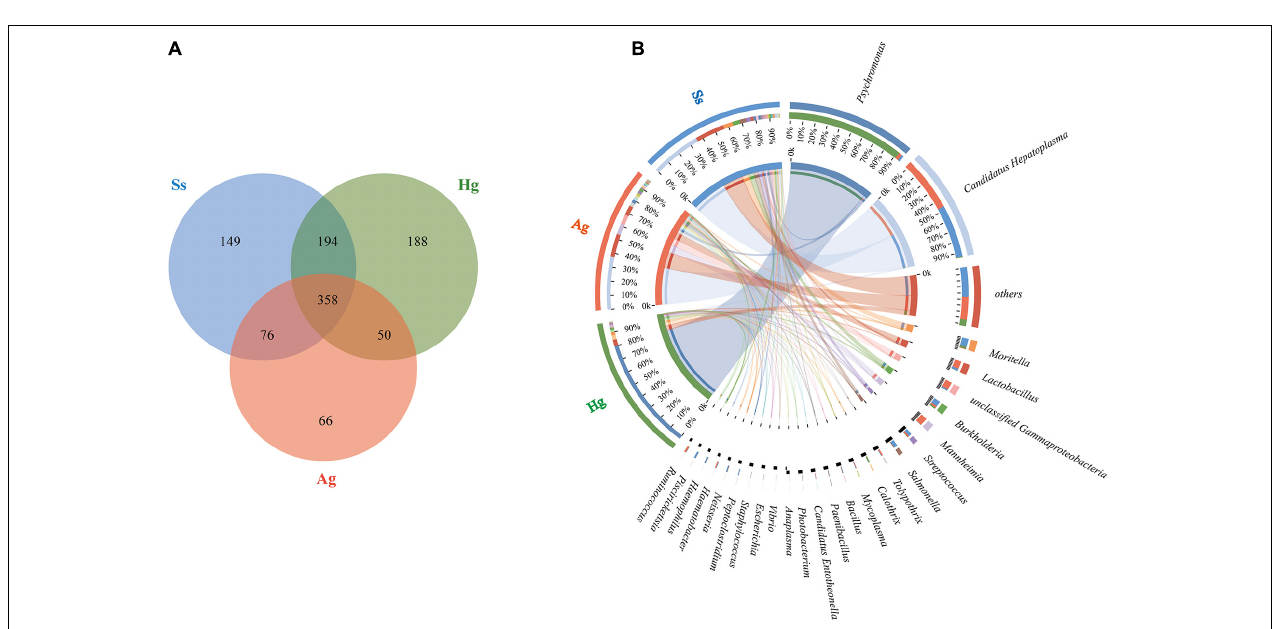
FIGURE 2 | Relative abundance of bacterial communities in intestine samples of hadal amphipods. Community compositions are displayed at phylum level and genus level. Genera totaling < 1% of samples were assigned as “Others.” Ag ( A. gigantea ), Hg ( H. gigas ), and Ss ( S. schellenbergi ) stand for different amphipod species.